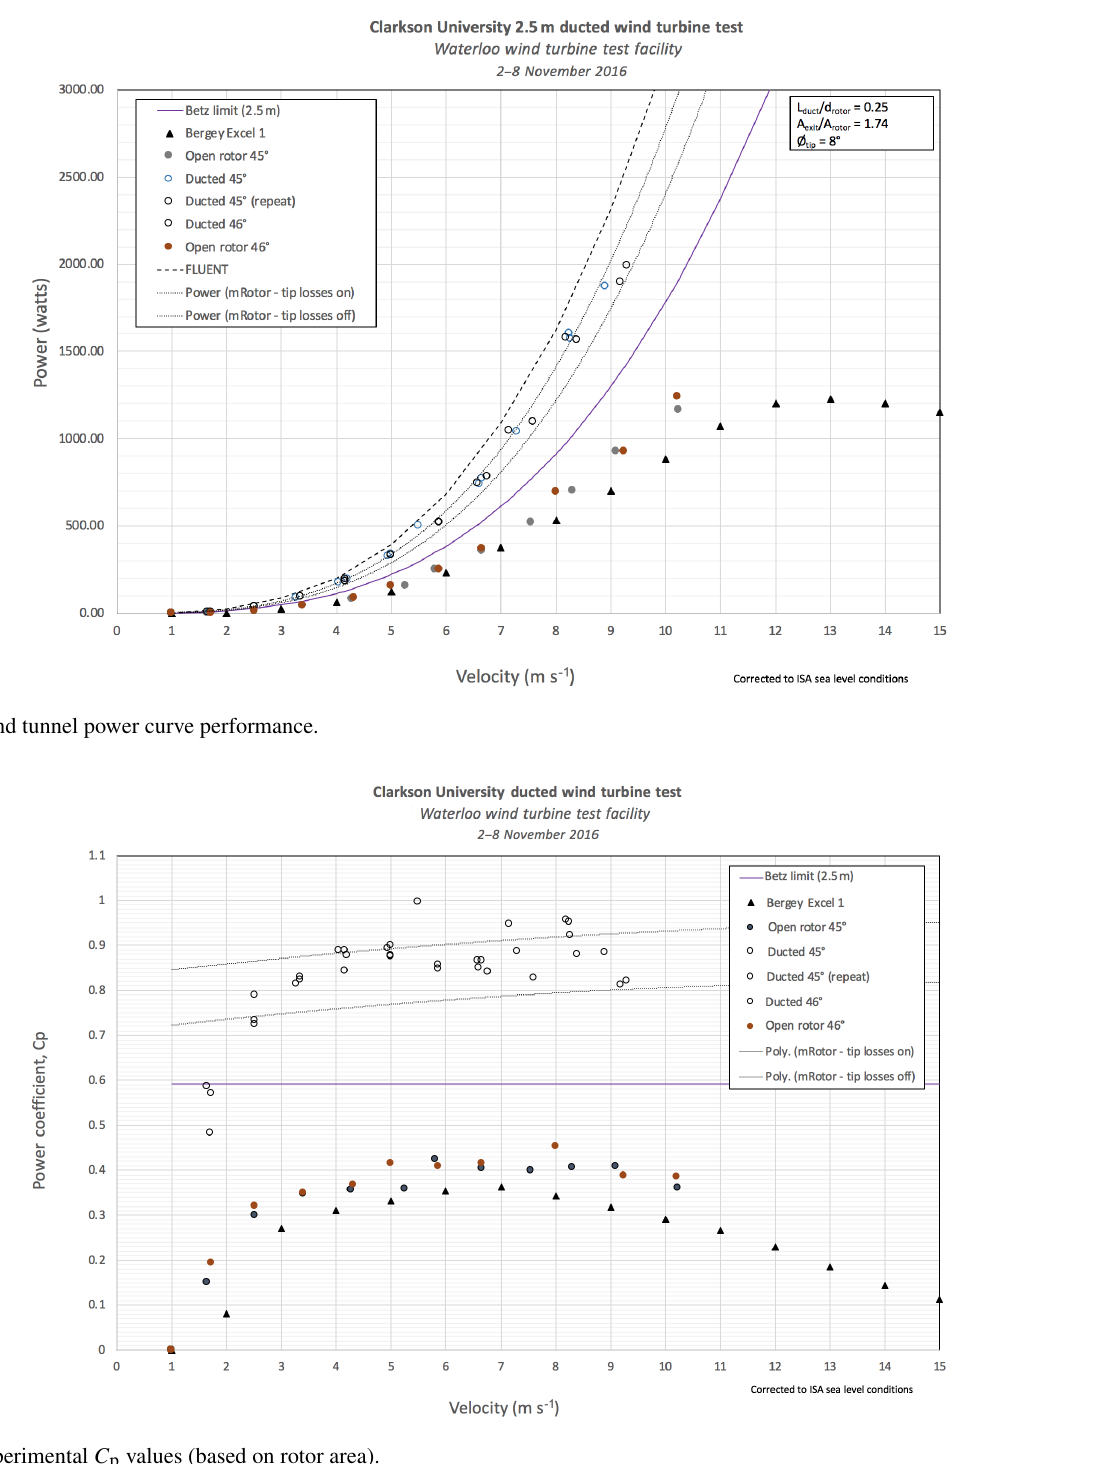
ation in a degree or two would not impact the performance